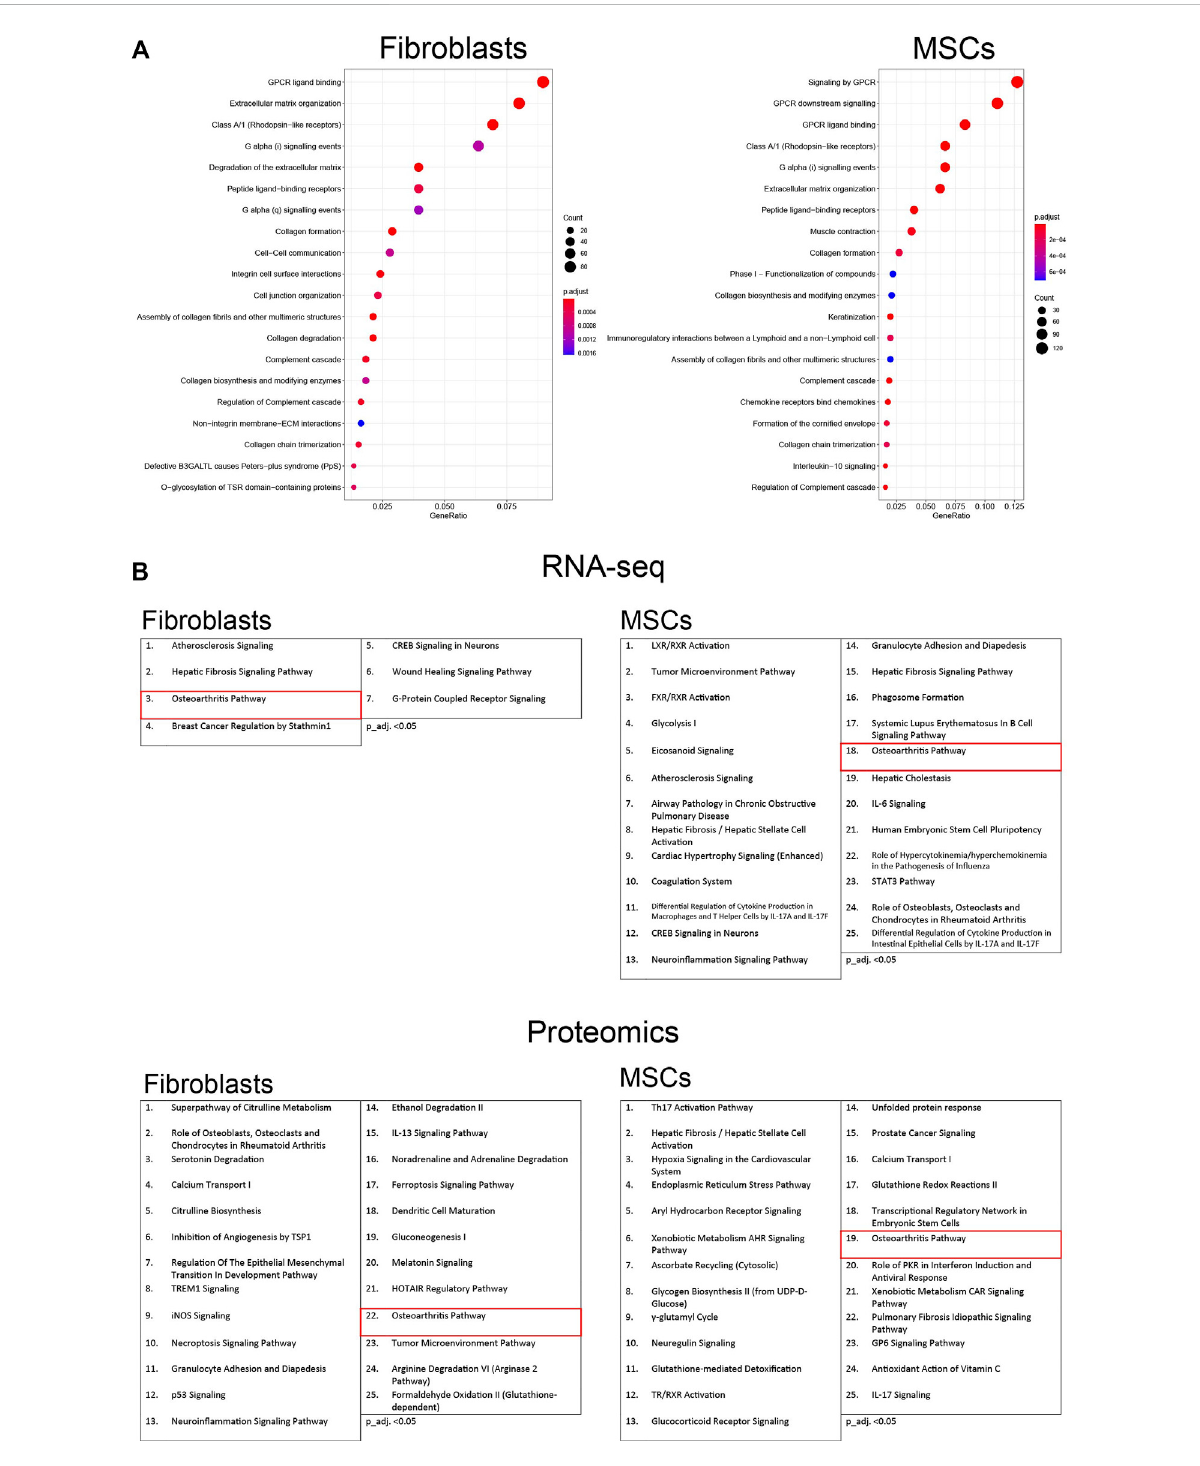
FIGURE 10 Pathway analysis of osteoblastic differentiated fi broblasts and MSCs. (A) The top 20 most signi fi cant gene sets, based on the most differentially expressed genes in osteoblastic differentiated fi broblasts and MSCs. Overrepresentation analysis (ORA) was conducted using R package clusterPro fi ler.Differentiallyexpressedgenesfortheenrichmentanalysiswerechosenusingadjusted p -valuethresholdof0.05andrequiringatleast 1.5-fold up- or down-regulation in expression. The p -values of enrichment analysis were adjusted for multiple testing using Benjamini – Hochberg procedure. Enriched terms were further visualized using clusterPro fi ler functions. (B) The top 25 enriched categories of